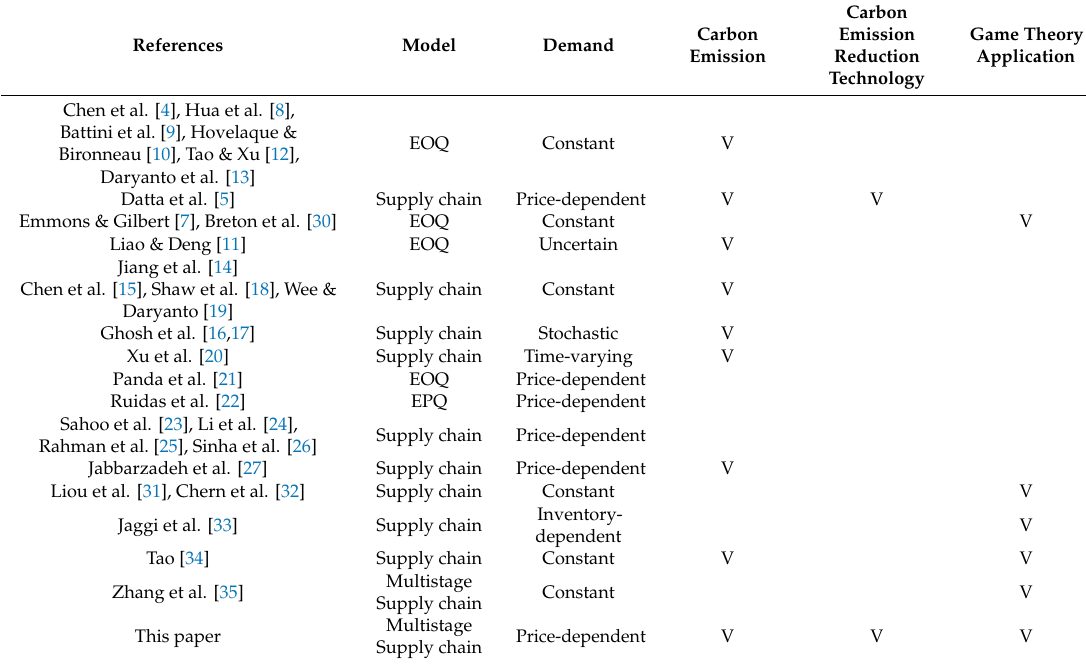
Table 1. Major characteristics of inventory models in relevant